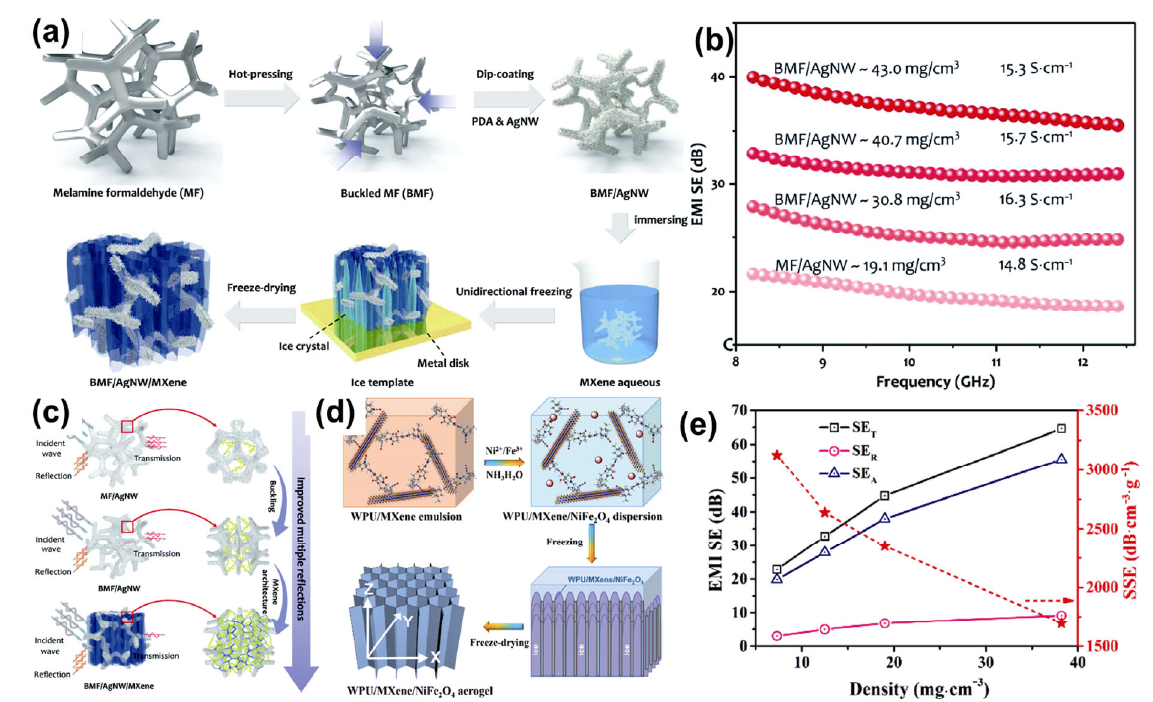
Fig. 32 (a) Fabrication process of the BMF/AgNW/MXene hybrid sponge. (b) EMI SE (X band) of MF/AgNW and BMF/AgNW sponges compressed with different volume ratios. (c) Schematic illustration of EMI shielding mechanisms for MF/AgNW, BMF/AgNW, and BMF/AgNW/MXene sponges. Reproduced with permission from Ref. [260], © Royal Society of Chemistry 2019. (d) Fabrication process of WPU/MXene/NiFe 2 O 4 hybrid aerogels. (e) Average EMI SE values and SSE